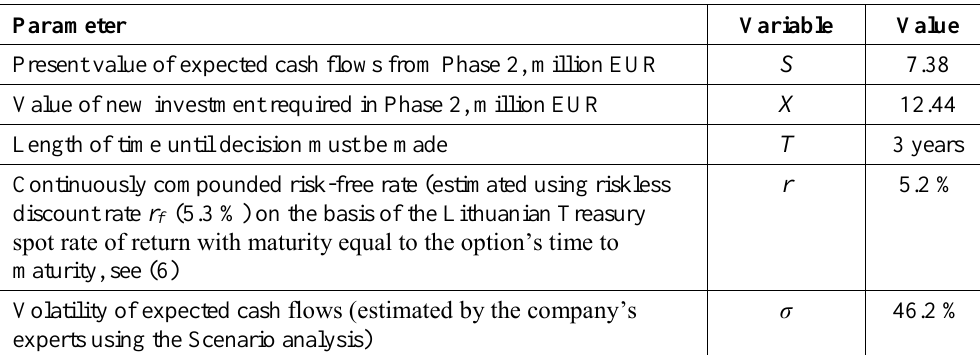
Table 5. Value of the